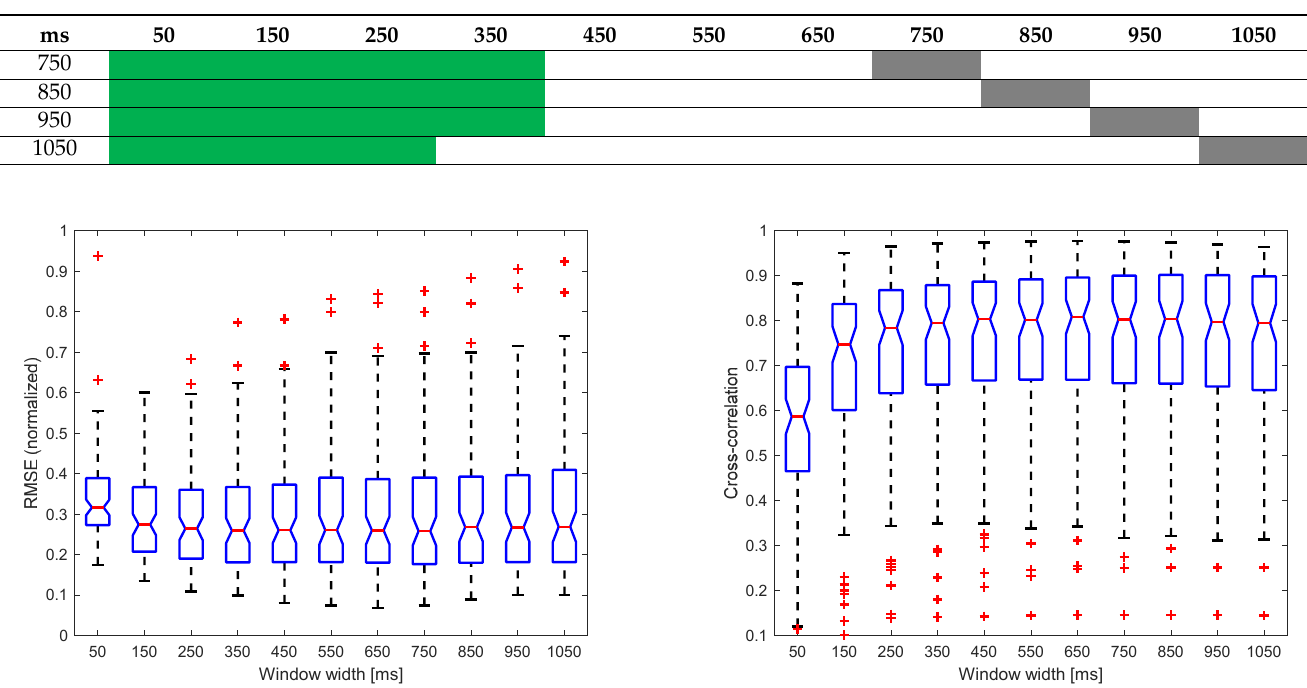
Figure A7. RMSE ( left ) and cross-correlation ( right ) of Tf_mod algorithm for different window sizes. Table A7. Statistical significance between window sizes for Tf_mod algorithm. Green indicates sta- tistically significant difference ( p < 0.05; Bonferroni-corrected) for the RMSE metric, and orange in- dicates significant difference ( p < 0.05; Bonferroni-corrected) for the cross-correlation metric. Grey indicates diagonal fields.